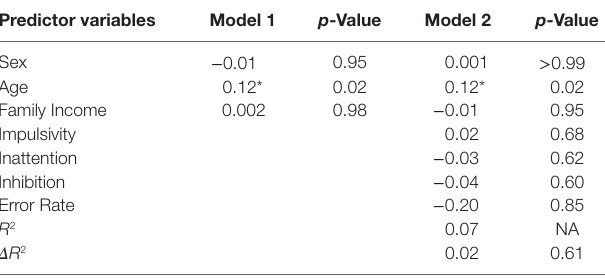
Table 8 | Sequential regression analysis of predictors of factor